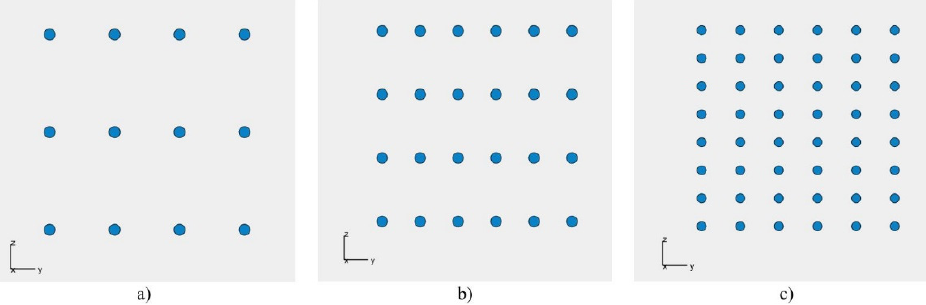
Figure 6. Square array in coordinate system, x being the broadside direction, with ( a ) 12 microphones; ( b ) 24 microphones; ( c ) 48 microphones.